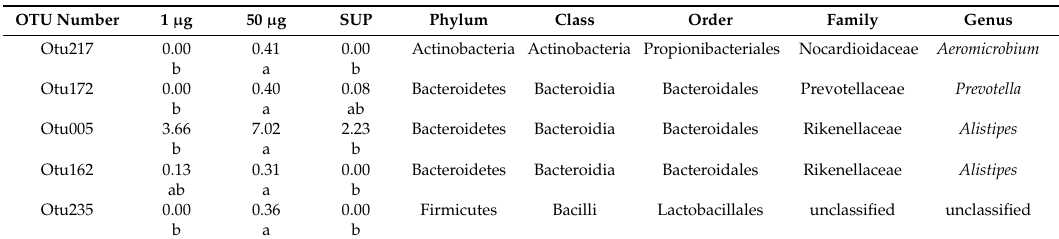
Figure 6. Lung microbiome beta: diversity analysis. Principal Component Analysis (PCA) plot generated from partial 16S ribosomal ribonucleic acid (rRNA) gene sequences clustered in operational taxonomic units (OTUs) with a 97% similarity level obtained from lung samples of two mice batches treated with either Ag50-PVP (batch 1) or Ag50-citrate (batch 2) NPs in different doses (1 µg, 50 µg) and the respective controls (SUP). The 10 most abundant OTUs are shown. Significant differences between the factors: coating/batch (Ag50-PVP/batch-1 vs. Ag50-citrate/batch-2) and dose (SUP, 1 µg, 50 µg), are indicated by p values < 0.05 (bold letters). Table 1. Mean relative abundance (%) of OTUs that are different between the dose groups in Ag50-citrate-treated lung samples ( n = 5).